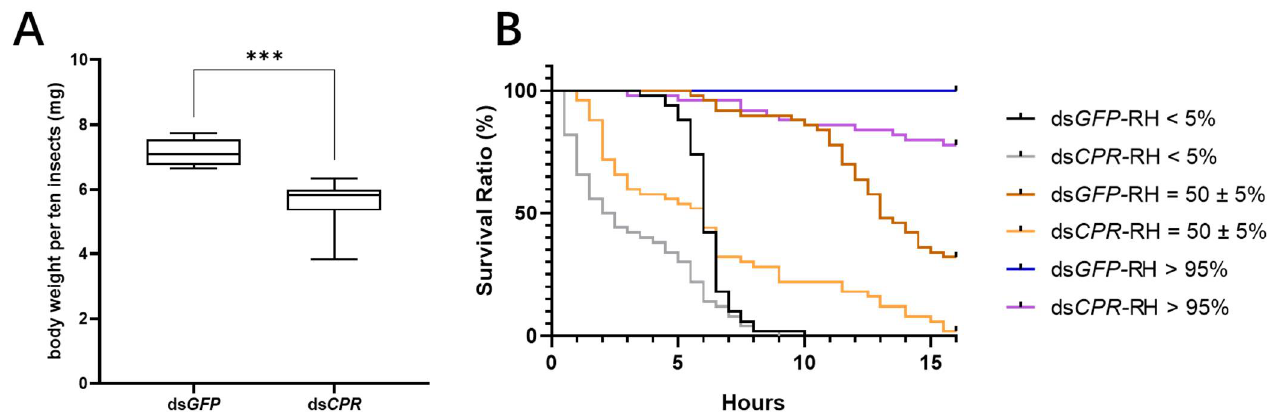
Figure 3. Observation of water retention in 5th-instar nymphs injected with dsRNA. ( A ) Measure- ment of body weights in dsRNA-treated adult females at 48 h after emergence under a relative humidity of 50 ± 5%. Body weights per ten insects were measured as a biological replicate. ds GFP - injected nymphs were used as a negative control. The data were calculated from nine biological replicates (mean ± SD). The asterisk ∗∗∗ indicate significant differences at p < 0.001 (Student’s t -test), difference from ds GFP . ( B ) Analysis of survival rates under different humidity treatments (relative humidity < 5%, = 50 ± 5%, and > 95%) following dsRNA injection. Effect of different humidity treatments on the survival time of adult females of ds CPR or ds GFP in the 5th-instar nymphs at 48 h post injection. Fifty insect individuals were counted each 30 min in both treatments. Each humidity treatment showed p < 0.01 (Log-rank (Mantel–Cox) test), difference from ds GFP